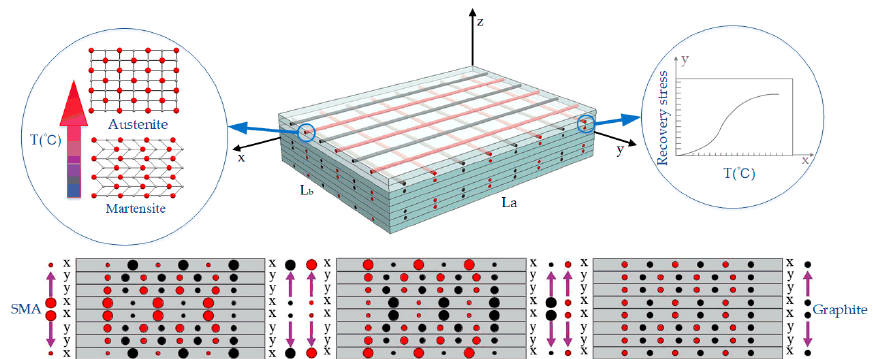
Figure 1. Schematic of an orthogonal gradient laminate that is reinforced by a two-phase fiber with nitinol/graphite.